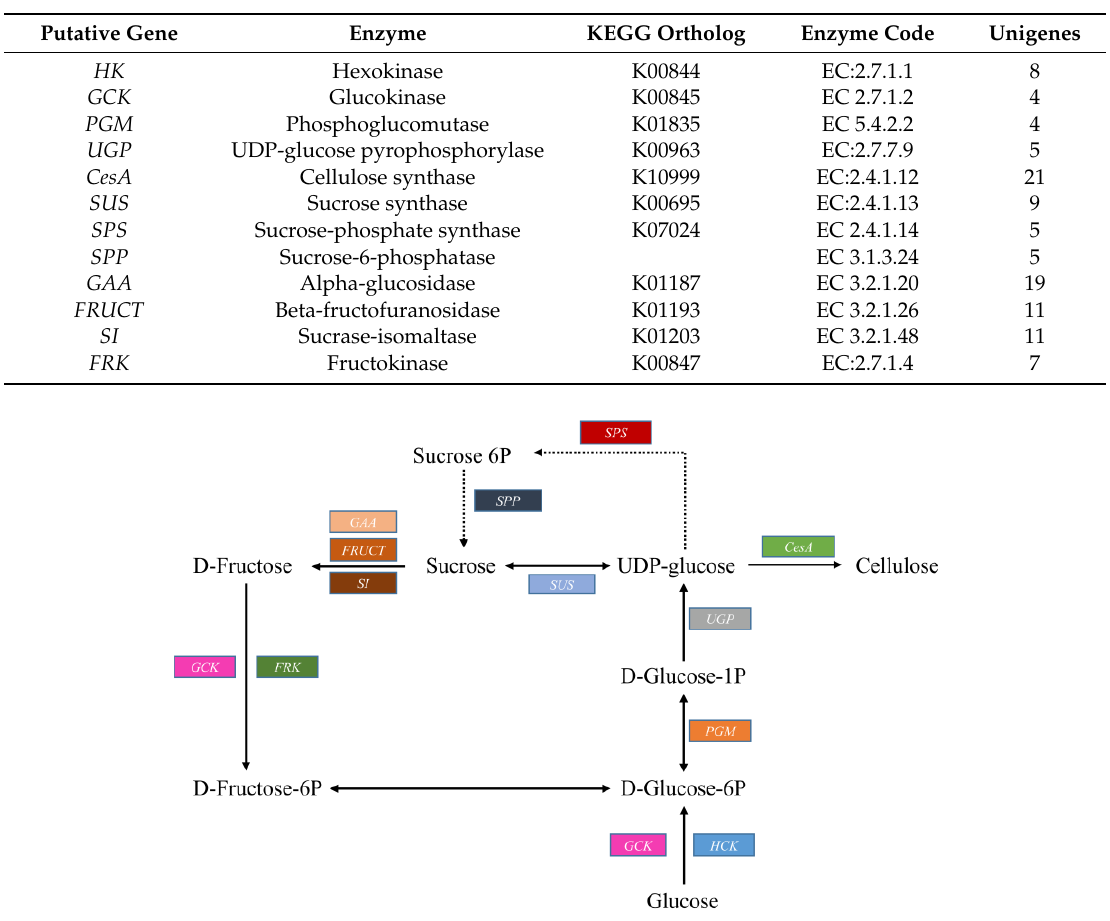
Figure 5. Hypothetical pathway constructed with kenaf unigenes (highlighted) involved in cellulose biosynthesis.